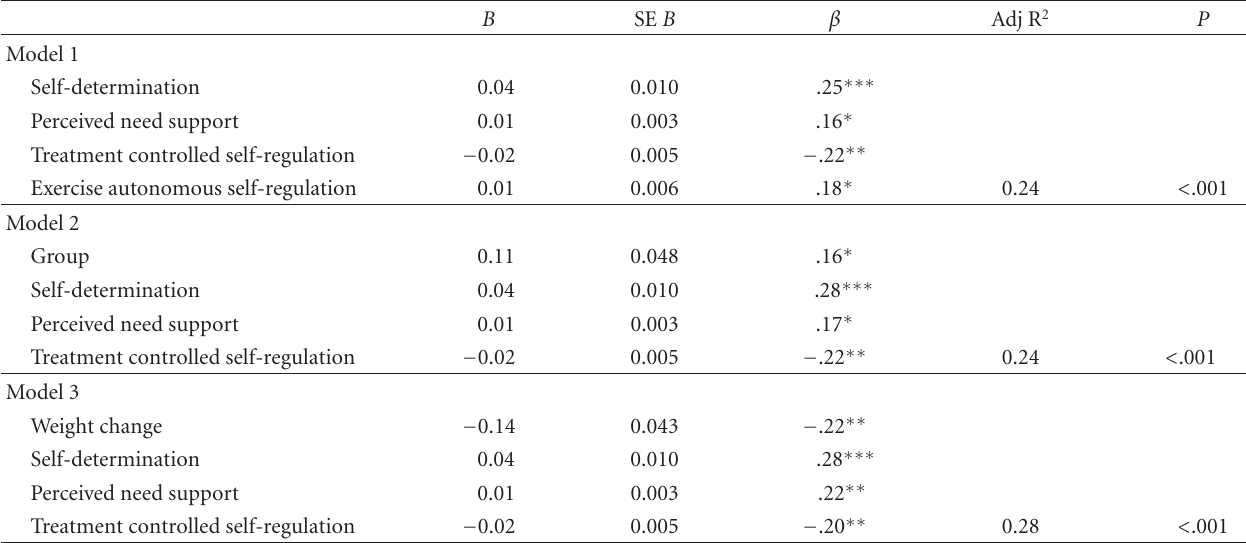
Table 2: Multiple regression for psychological well-being z-score at intervention’s